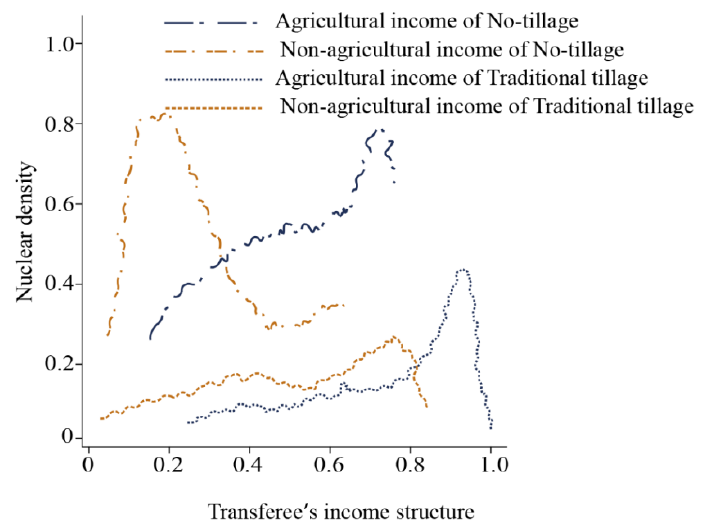
Figure 5. Nuclear density curve between transferees’ NT technology adoption and family income structure (Source: field survey 2019).